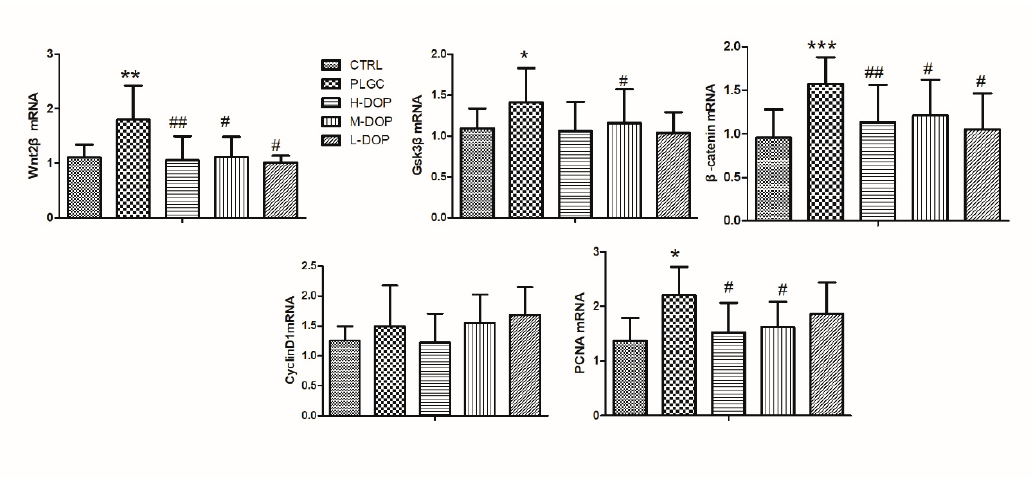
Figure 2. The effect of DOP on Wnt2 β , Gsk3 β , PCNA, and β -catenin gene expression. Results from administering DOP 7 months on PLGC rat model. The relative expression for a particular gene was calculated by using Ct method, a comparative 2 − ΔΔ CT method. Data was presented as mean ± SEM (n = 6). Statistical analyses were carried out by using one-way ANOVA and Tukey post-hoc test. * p < 0.05, ** p < 0.01 and *** p < 0.001 vs CTRL; # p < 0.05 and ## p < 0.01 vs PLGC model.